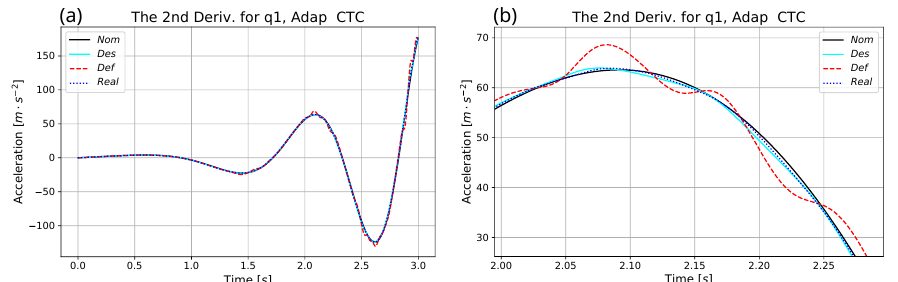
Figure 15. Second time derivatives for q 1 ( a ) and the zoomed-in excerpts ( b ) for the adaptive CTC controller using the identified parameters.